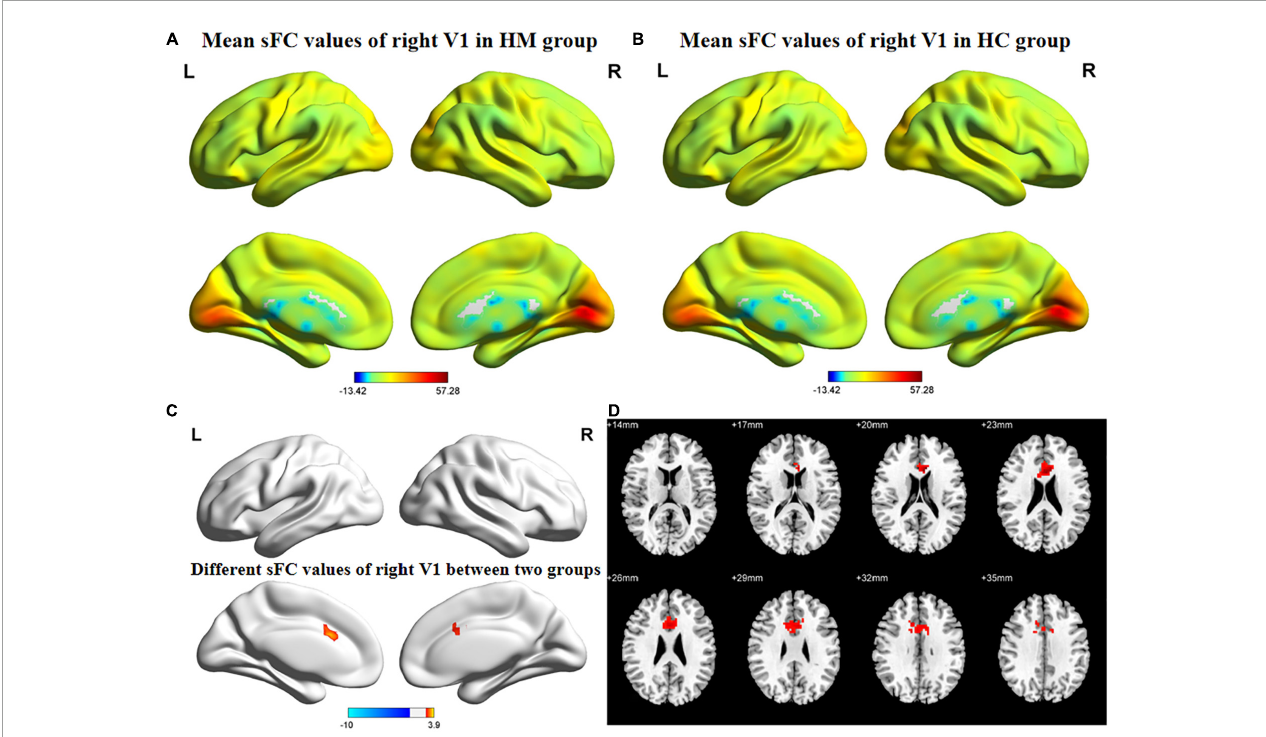
FIGURE2 Spatial of distributions of sFC patterns of the right V1 in HM patients and HCs. (A) Mean sFC values of right V1 in HM group; (B) mean sFC values of right V1 in HC group; (C) different sFC values of right V1 between two groups and (D) significant zsFC maps of right V1 differences among two groups. HCs, healthy controls; HM, high myopia; sFC, static functional connectivity; zsFC, z-values static functional connectivity; L, left; R,